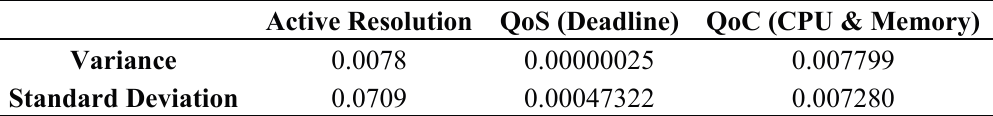
Table 5. Variance and standard